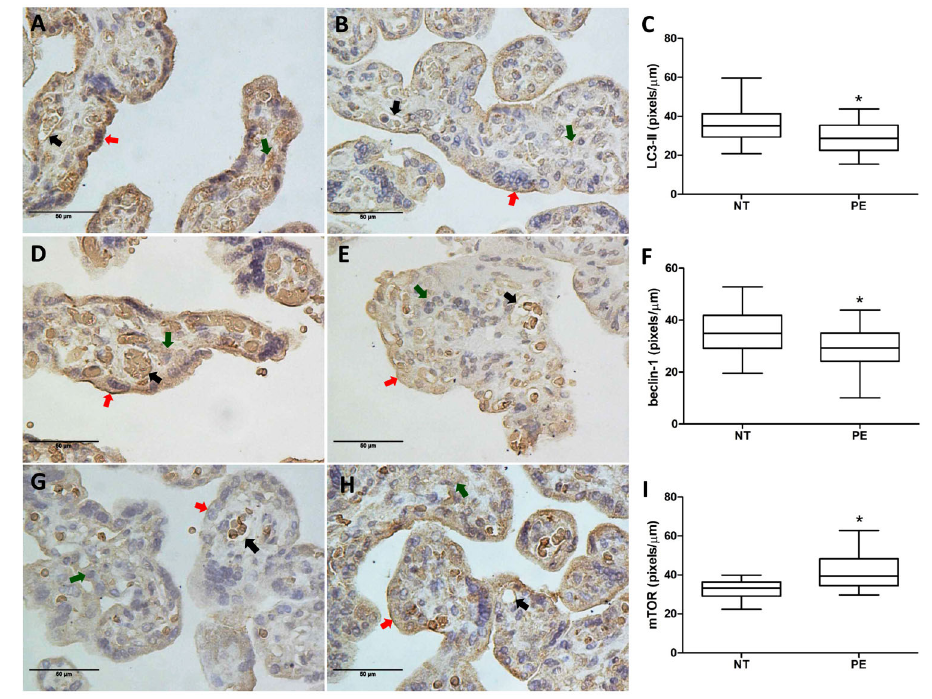
Figure 2. Immunohistochemical staining and quantitative analysis of LC3-II ( A , B , and C ), beclin-1 ( D , E , and F ), and mTOR ( G , H , and I ) in the placenta from 20 normotensive pregnant women (NT) and 20 pregnant women with preeclampsia (PE). The red arrows show positivity in the syncytiotrophoblast, the green arrows show positivity in the cytoplasm of mesenchymal cells, and the black arrows show positivity in the fetal capillary endothelium. Results are reported in pixels/ m m and as median (horizontal line), 25th and 75th percentiles (box), and range (whiskers). *P o 0.05 vs NT (Mann-Whitney U